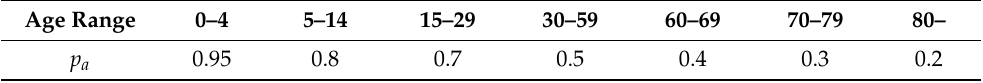
Table A3. The probability of becoming an asymptomatic patient ( p a ) for different age groups